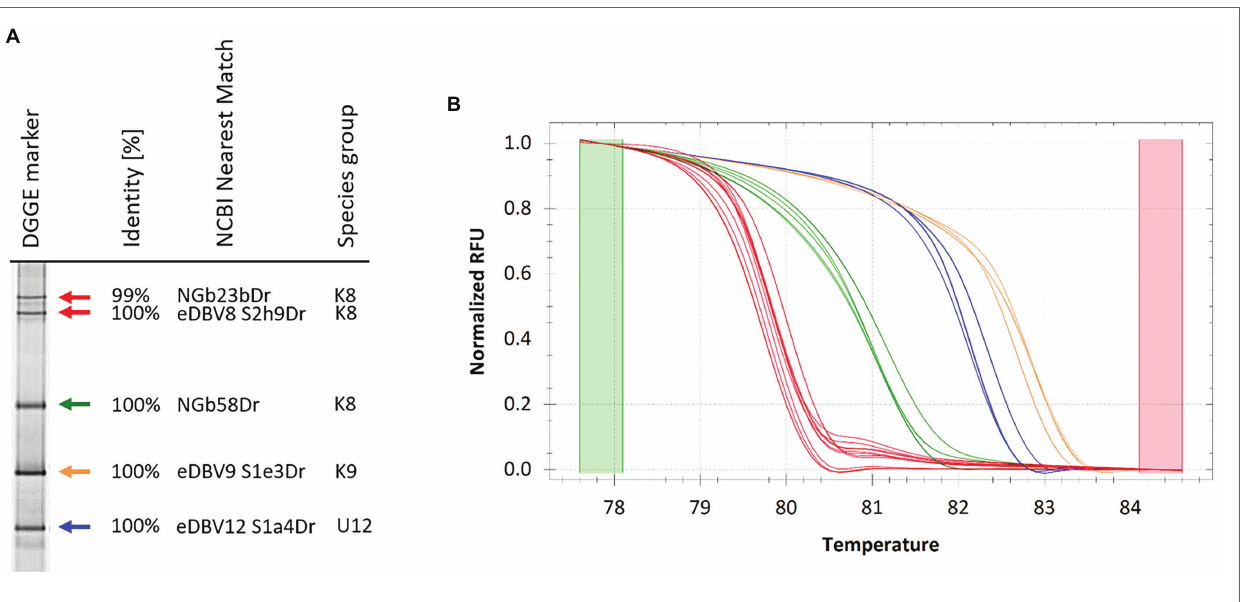
FIGURE 6 | DGGE marker for quick identification of endogenous badnavirus sequences in yam germplasm and high-resolution melt (HRM) verification of amplification products following qPCR. (A) DGGE sequence marker extracted from DGGE analysis presented in Figure 2 and closest NCBI BLAST identity search results are indicated including monophyletic species group assignments K8 and K9 described by Kenyon et al. (2008) and U12 by Umber et al. (2014). Colour coded arrows correspond to normalized melt curves of HRM analysis shown in (B) . Several cloned DGGE band sequences were verified by HRM ( Supplementary Table S3 ) following qPCR amplification confirming sequence identification based on the band position compared to the DGGE marker ( Figure 2 ) and the sequencing results ( Table 1 ). Melt curves of same colour indicate near identical sequences clustering together in HRM